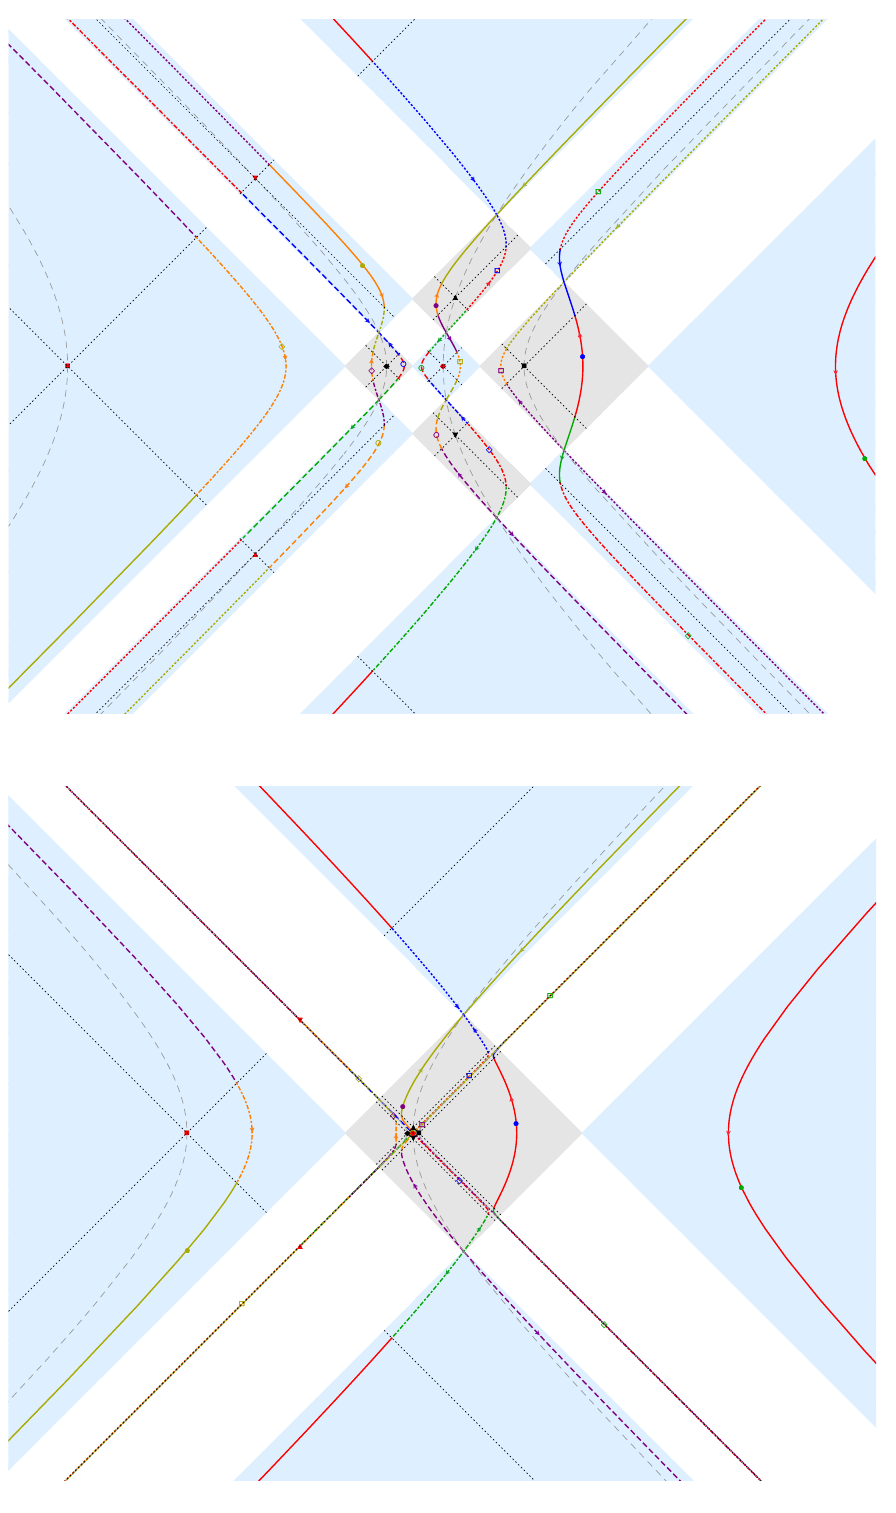
Figure 13 . Modular trajectories in D A and their images under the inversion map (7.30). The 1 ∪ A 2 bottom panel shows the limiting regime of adjacent intervals (see the right panel of figure